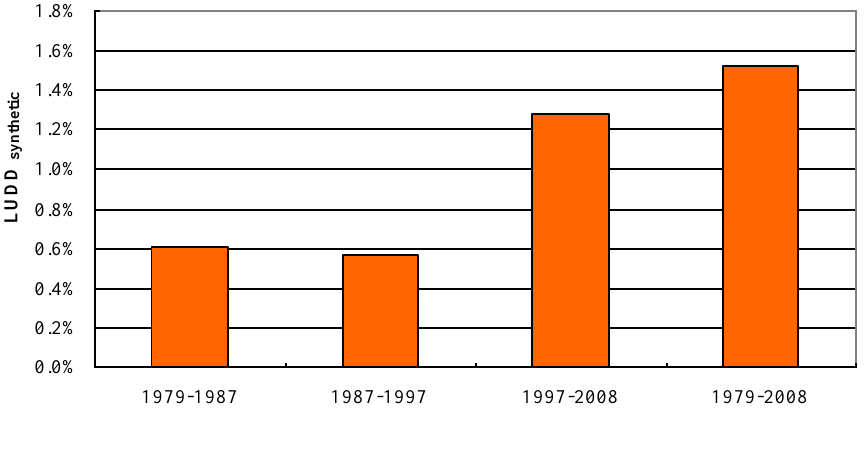
Figure 3. The synthetic land use dynamic degree of study area in